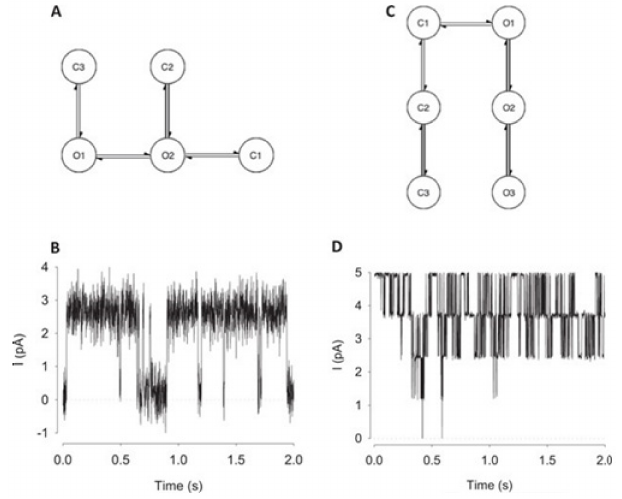
Figure 12. “Patch-clamp” data were produced from two different stochastic models. ( A , C ) The Markovian models simulating the ion channel data. Ion channels move between closed (0 conduc- tance) and open (unitary-conductance, g) states. In many cases, there are many open and closed states (“O1”–“O3”, or “C1”–“C3”, respectively). The central dogma of ion channel research is that the g will be the same for O1, O2, or O3. Although substates have been identified in some situations, these are beyond the scope of our current work. ( A ) Model M1; the stochastic model from ref. [68] and its output. ( B ) It has a low open probability, so the data is a representation of the 0 or a channel openning state. ( C ) Model M2; the stochastic model, and an output data ( D ) since the open probability is high, the signal is found to be largely composed of 3 or more ion channels that are simultaneously